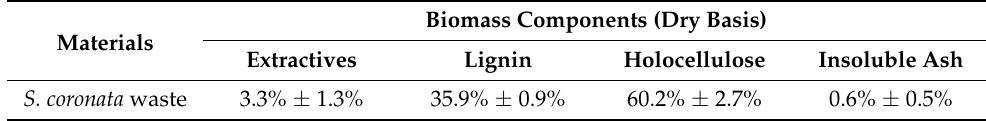
Table 2. Mass distribution of macro components of S. coronata